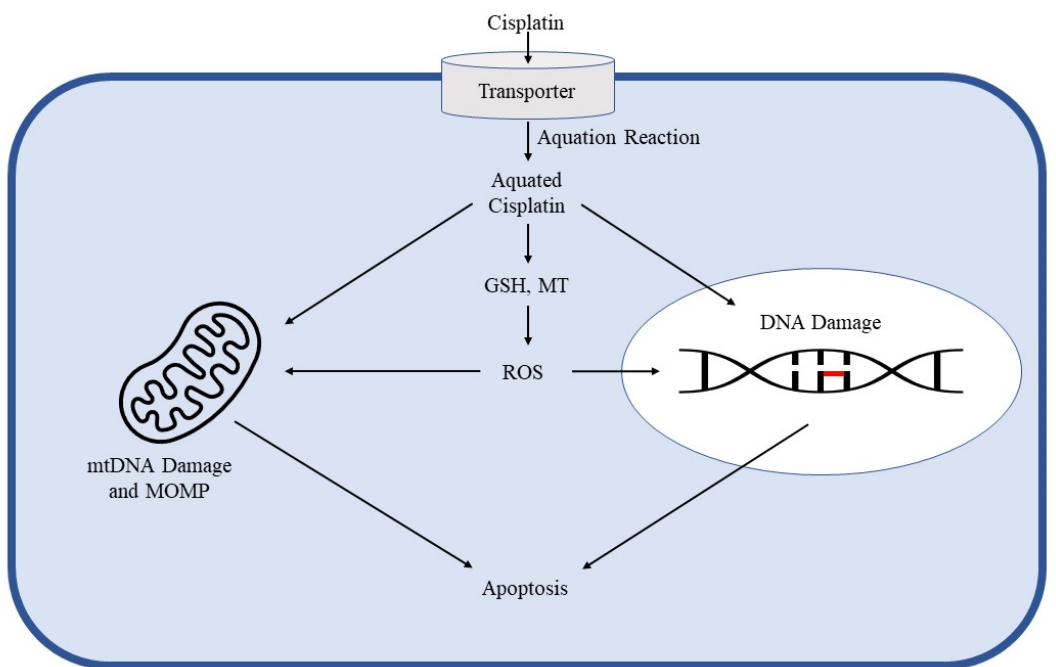
Figure 1. Mechanisms of cisplatin therapeutic action. The dark blue border represents the cell membrane, with the light blue interior being the cytosol and the white oval being the nucleus. Cisplatin first undergoes cellular uptake mediated by copper transporters, indicated by the cylindrical structure crossing the cell membrane. It is then activated in the cytosol through aquation. Aquated cisplatin induces nuclear DNA damage, such as the intrastrand crosslinks represented by the red bar linking two adjacent DNA bases, and mitochondrial DNA damage. The activated drug also attacks reduced glutathione (GSH) and metallothionein (MT) to generate reactive oxygen species (ROS). ROS generation induces apoptosis through mitochondrial outer membrane permeabilization (MOMP) and DNA damage.